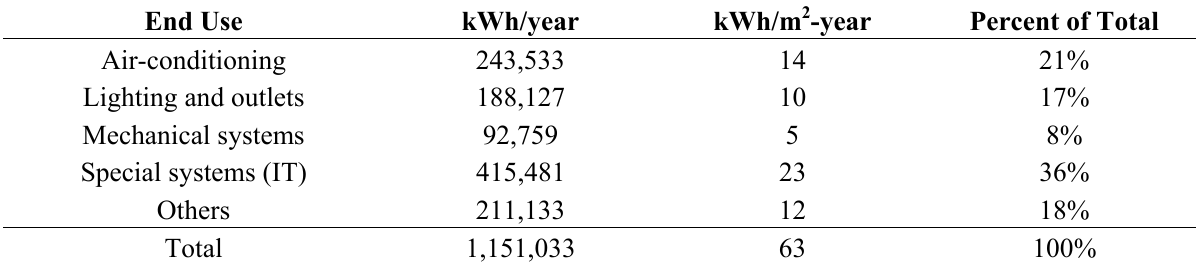
Table 3. Annual end uses: cooling, lighting and plug loads, mechanical, and IT